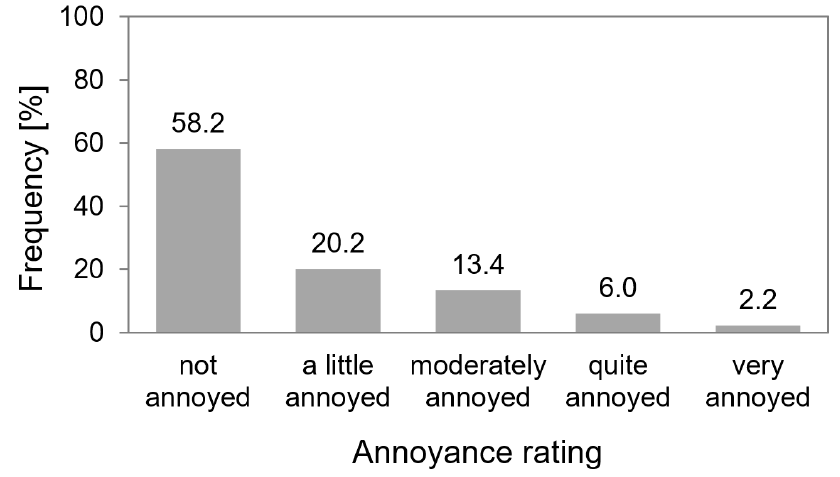
Figure 1. Percentage distribution of aircraft noise-induced short-term annoyance due to exposure of the previous night ( N = 48 subjects, 134 nights).